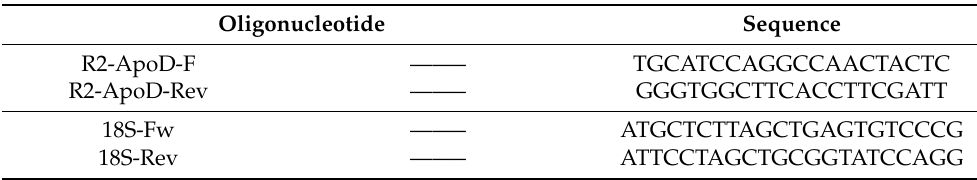
Table 1. Primers used for qRT-PCR in this